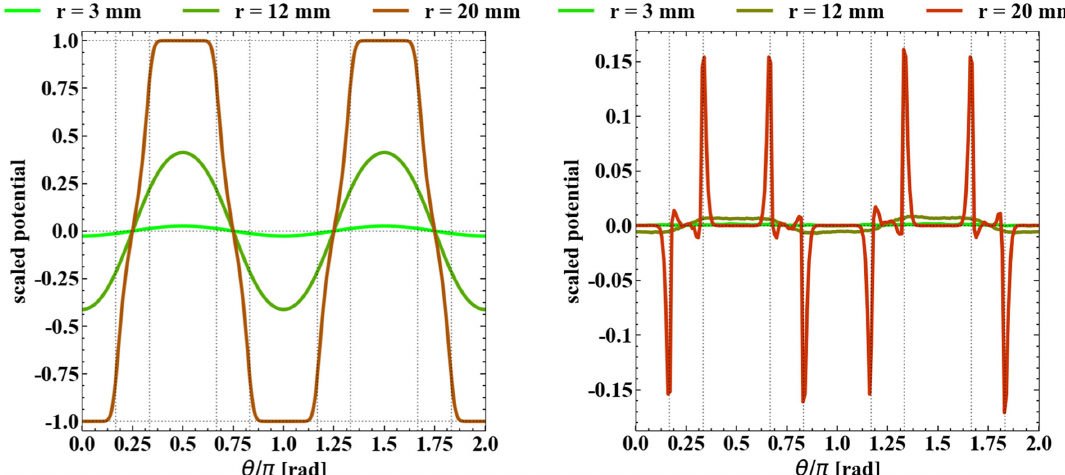
8. Left: Potential (using the projection method) in the quadrupole mode as a function of θ for 3 values of r , the largest r ¼ b with θ π = 6 and a ¼ 25 mm, b ¼ 20 mm. Note that for the quadrupole, 0 < θ 0 ¼ and FEMM values for the potential. The difference reaches 15% at the tips of the plates but is less than 5% everywhere